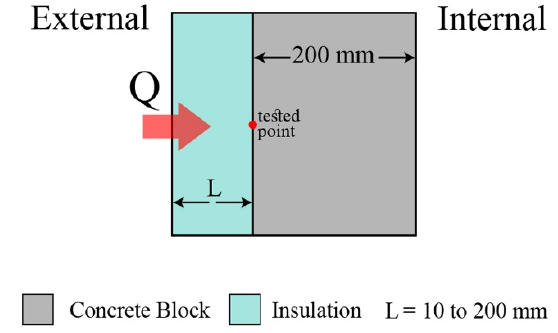
Figure 16. Finite element analysis model.